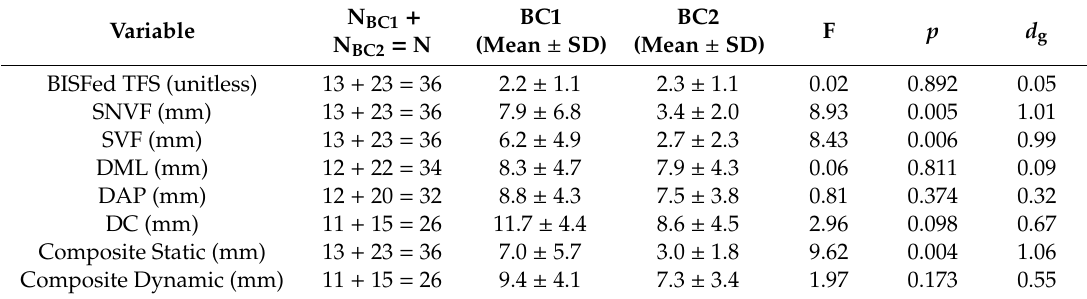
Table 4. Descriptive statistics and ANOVA (one factor) about mean radial error